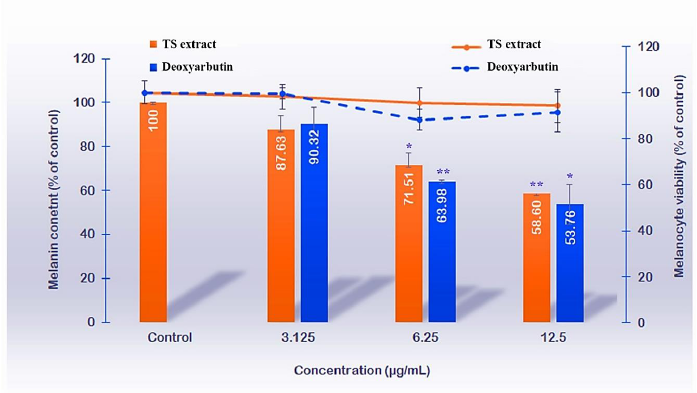
Figure 2. The anti-melanogenesis effects of the tamarind seed coat (TS) extract and deoxyarbutin were displayed by melanin content reduction (bar) at non-cytotoxic concentrations ⎯ given >80% cell viability of control (line). The significant effect was detected at 6.25 and 12.5 μg/mL TS extract (or deoxyarbutin) concentration, compared to the control (* p -value < 0.05; **, p -value < 0.01). 2.3. Anti-adipogenesis of TS Extract in a 3L3-T1 Adipocyte Cell Line Model The TS extract manifested inhibitory effects on the differentiation and adipogenesis of adipocytes. The non-cytotoxic concentration range of TS extract (0 – 31.25 µg/mL) with adipocyte viability of more than 80% of control (Figure 3A). At low concentrations (1.25 – 10 µg/mL), suppression of intracellular lipid accumulation and biotransformation of fatty acids into triglycerides, a deposited insoluble lipid form, signified the anti-adipogenesis of the TS extract. Compared to the control (differentiated adipocytes in Figure 3(C1)), the TS extract treated group showed the reduction of Oil Red O-stained lipid droplets in terms of sizes and numbers (Figure 3(C3 – C6)) with a comparable character to the control (Figure 3(C2)) at a concentration of 10 µg/mL (Figure 3(C6)). Relatively, total lipid accumulation and triglyceride content were significantly diminished in a dose-dependent manner with statistical significance in a concentration range of 5 to 10 µg/mL for total lipid accumula- tion of 81.20 2.91 and 25.82 2.44% of control and 2.5 to 10 µg/mL for triglyceride accu- mulation of 70.09 2.80, 41.12 5.84, and 8.41 2.35% of the control, respectively (Figure 3B).